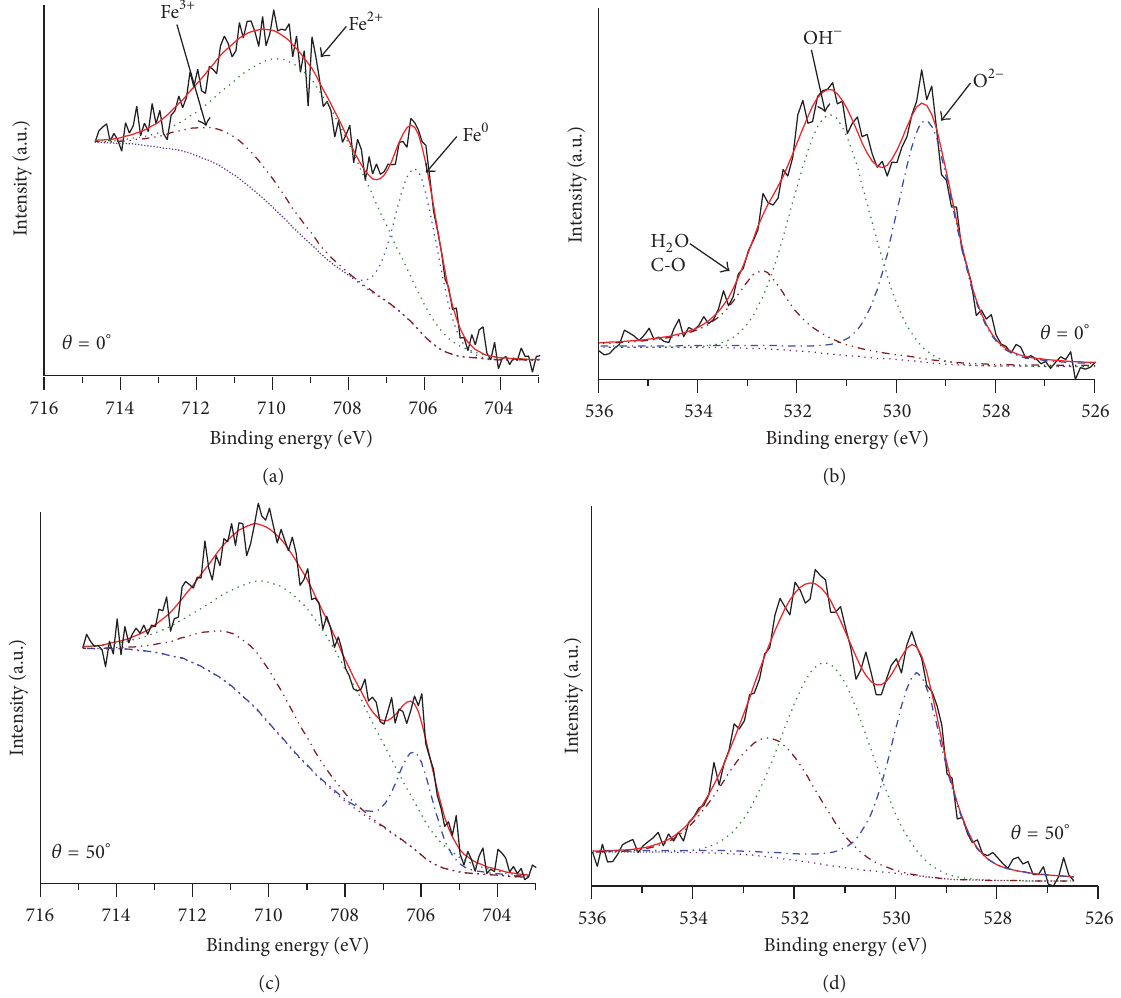
Figure 10: High resolution Fe 2p 3/2 and O 1s spectra for native oxide film, obtained at a takeoff angle of 0 ∘ (a, b) and of 50 ∘ (c,